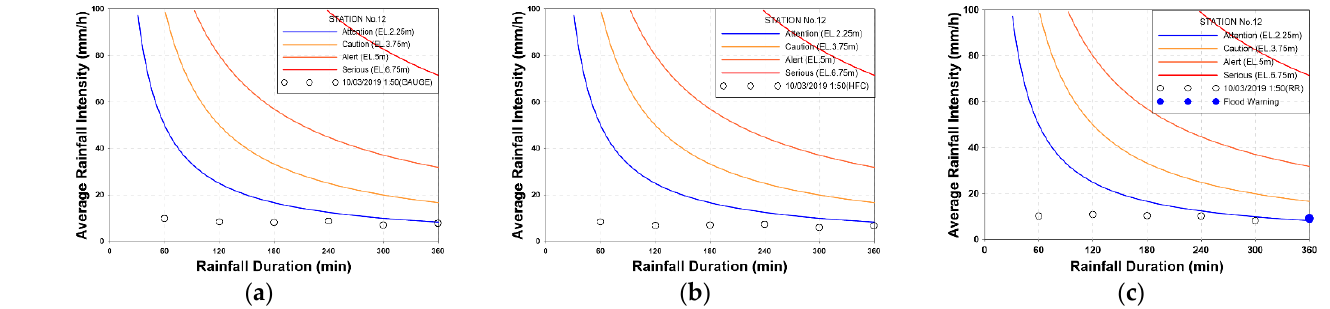
Figure 9. Calculation results of the flood forecast information for October 3 2019, at 01:50: ( a ) Ground rain gauge; ( b ) CMP_HFC; ( c ) SAM_RR.